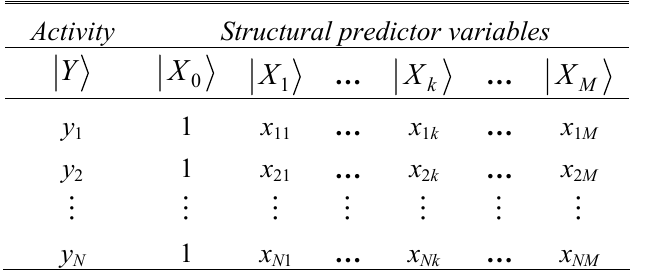
Table 1: The vectorial descriptors in a Spectral-SAR